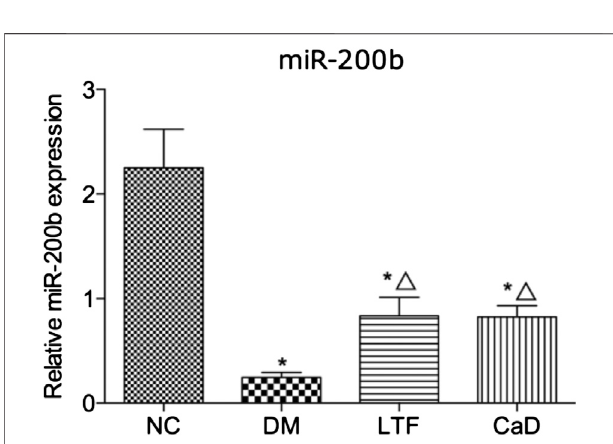
FIGURE 6 | qRT-PCR of retinal miR-200b expression. Data are mean ± SDfromsixratspergroup,andtheexperimentswererepeatedindependently four times.(* p < 0.05: vs. NC group; △ p < 0.05: vs. DM group).